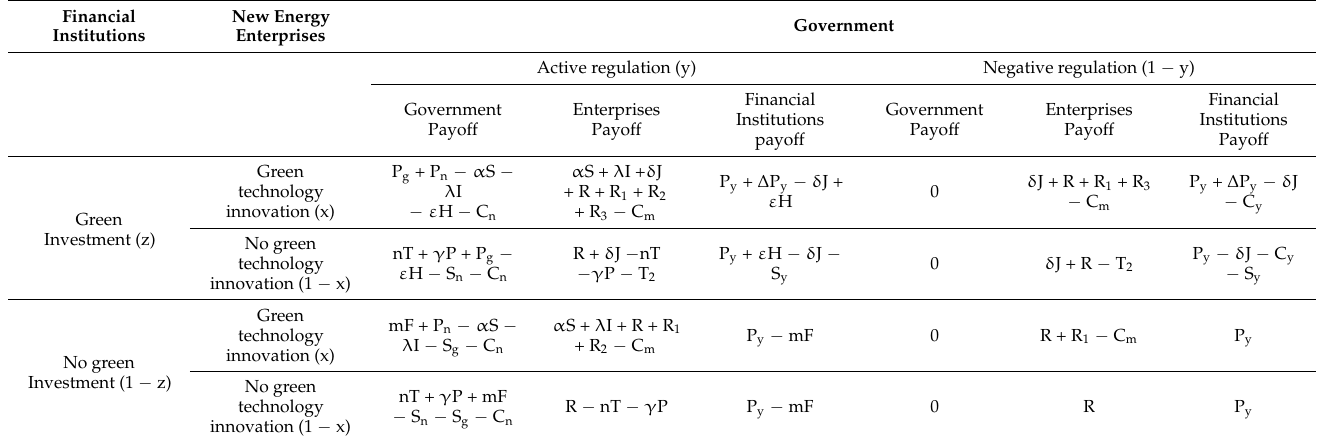
Table 2. Payoff matrix among the new energy enterprises, government and financial